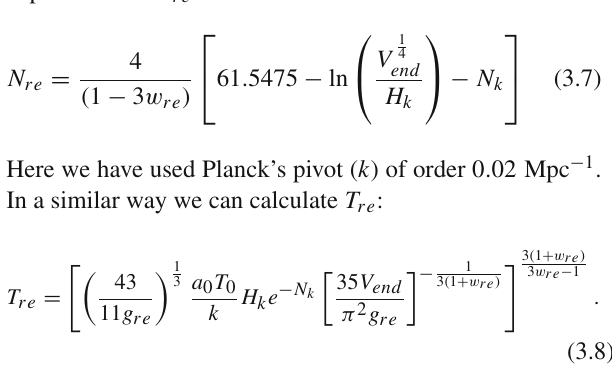
The light pink shaded region corresponds to the 1- σ bound and the yellow shaded region is 2- σ bound on n s from Planck’18 [TT,TE, EE+lowE+lensing+BK15]. The dark pink shaded region corresponds to the 1- σ bound of future CMB observations using same central value for n s